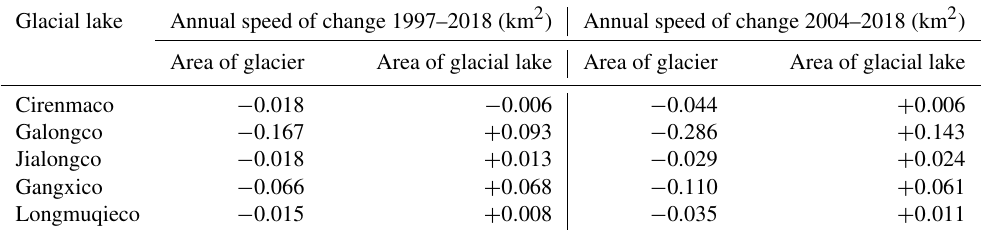
Table 9. Annual rates of change in five typical glacial lakes and their glaciers. Glacial lake Area of glacier Area of glacial lake Area of glacier Area of glacial lake Cirenmaco − 0.018 − 0.006